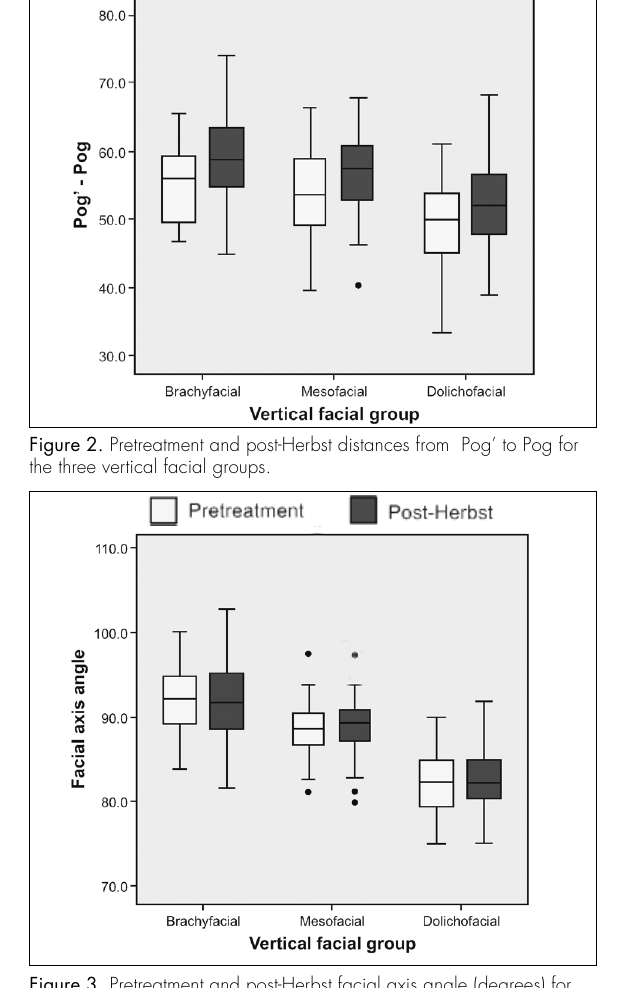
Figure 3. Pretreatment and post-Herbst facial axis angle (degrees) for the three vertical facial groups.